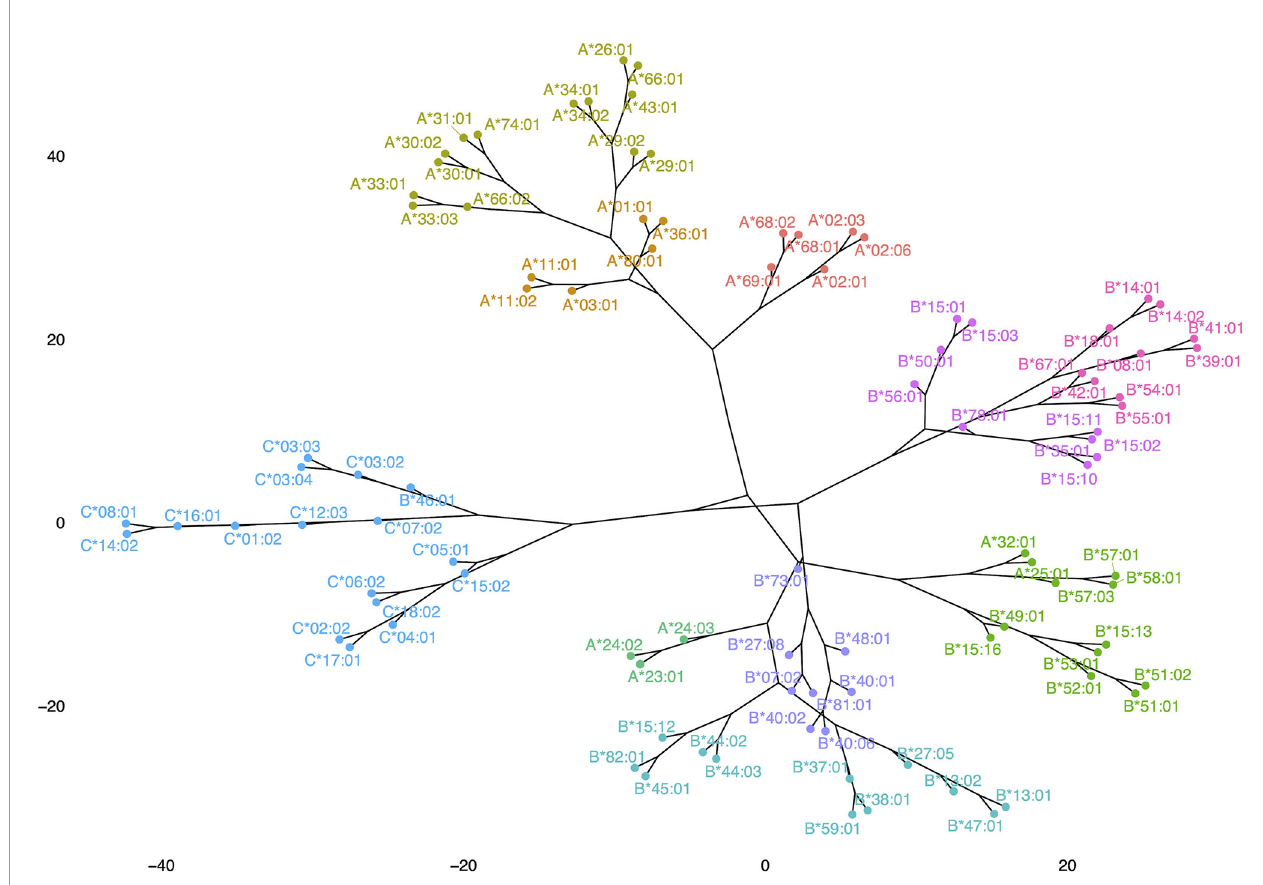
FIGURE 8 | Representation of anti-HLA class I immune responses as a dendrogram produced for Minkowski calculated distances of antigen-speci fi c feature